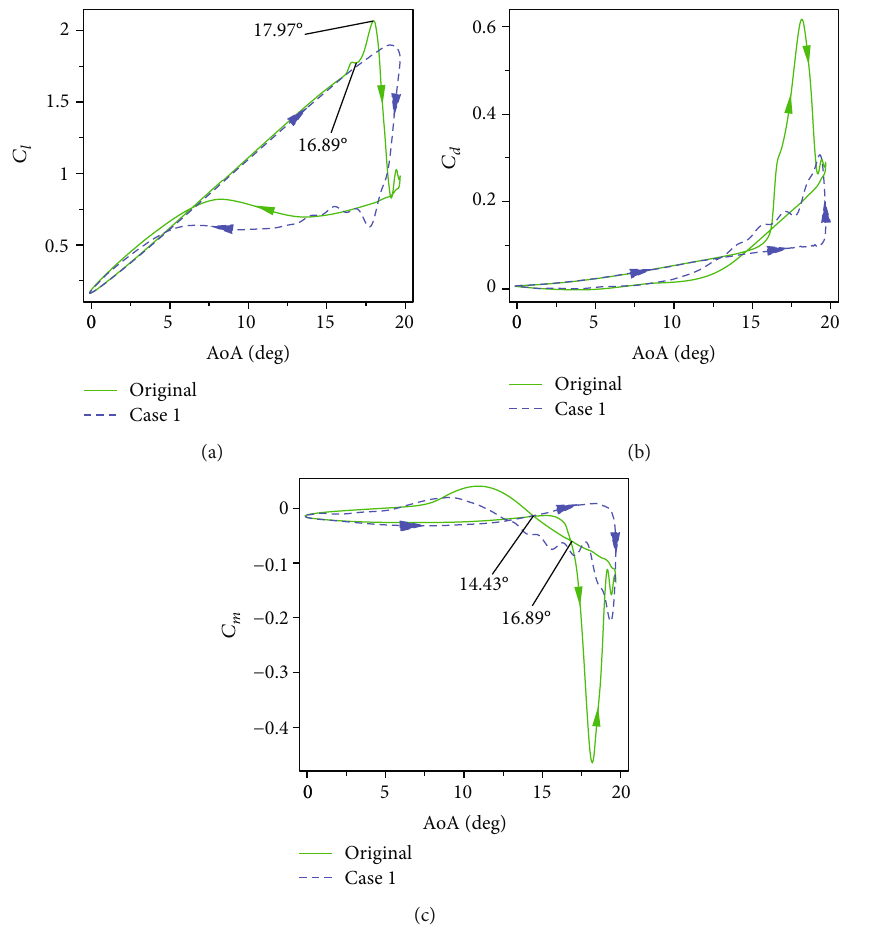
Figure 13: Comparison of aerodynamic coe ffi cients between the original airfoil and the ILE airfoil in Case 1: (a) lift coe ffi cients, (b) drag coe ffi cients, and (c) pitching moment coe ffi